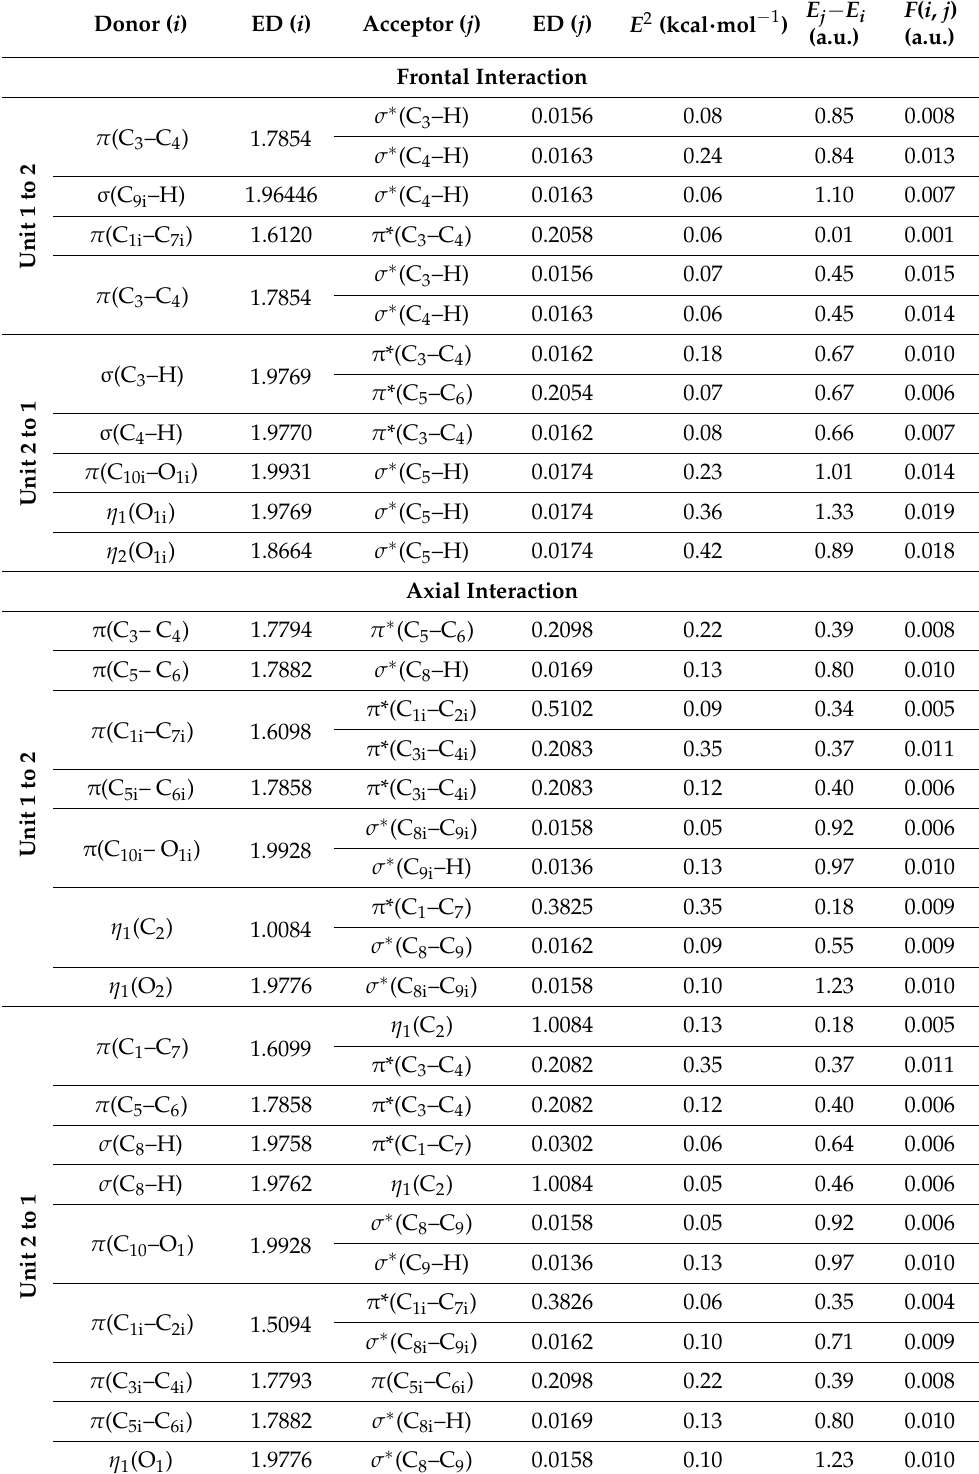
Table 4. Second-order perturbation theory analysis in NBO basis obtained at M06-2X/6-311G(d,p) level of theory for